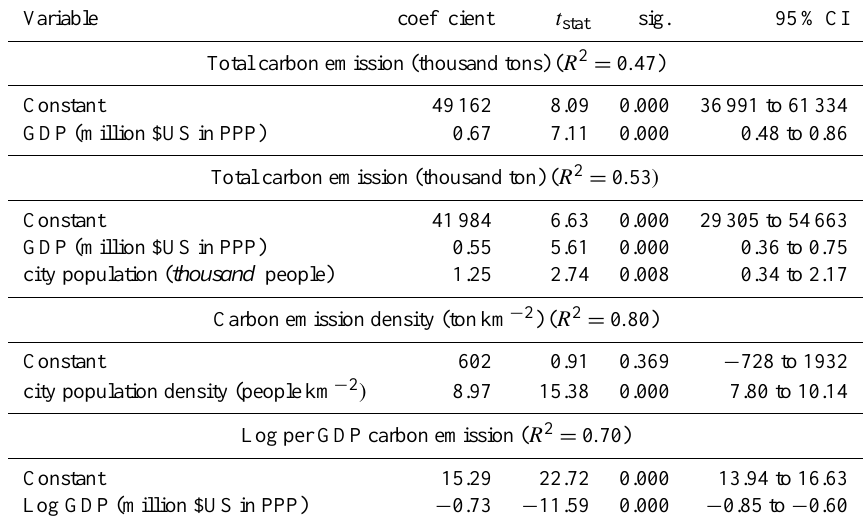
Table 1. Linear Regression Analysis for the Carbon Emissions of 12 Chinese